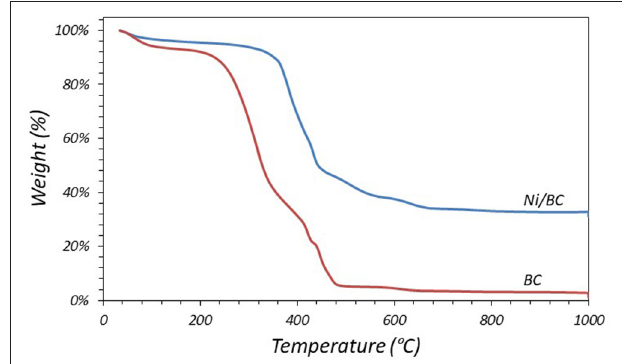
FIGURE 2 | TGA-Air analyses for biomorphic carbon and Ni/BC catalyst.